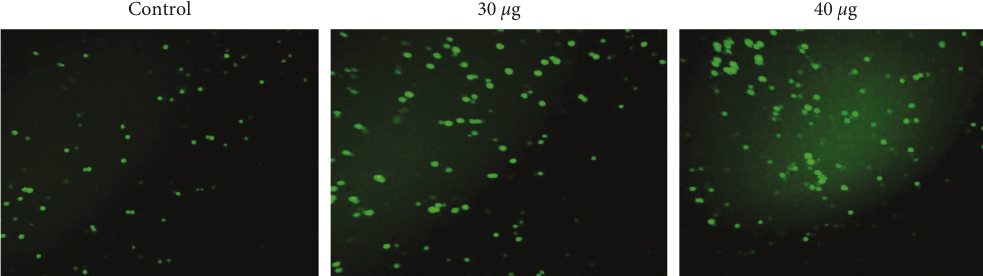
Figure 8: In the MOLT4 cell line, CTCANc produced intracellular ROS. The oxidative stress caused by nanocomposites was stained with DCFH-DA.